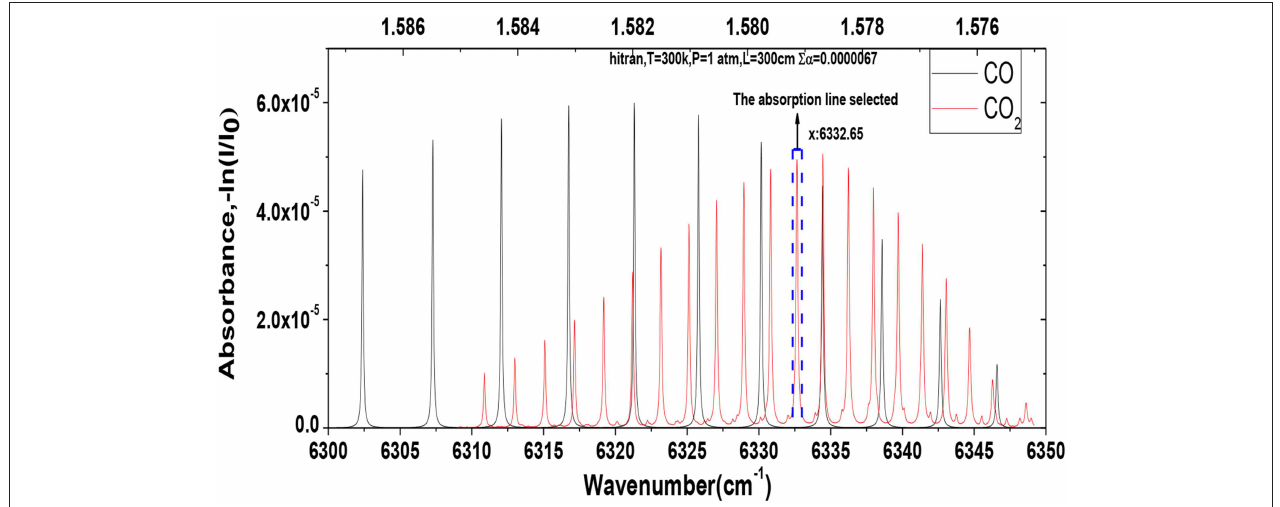
FIGURE 2 | The simulated absorption lines of CO 2 and CO at room temperature and atmospheric pressure in the region of 6,300 to 6,350 cm − 1 .